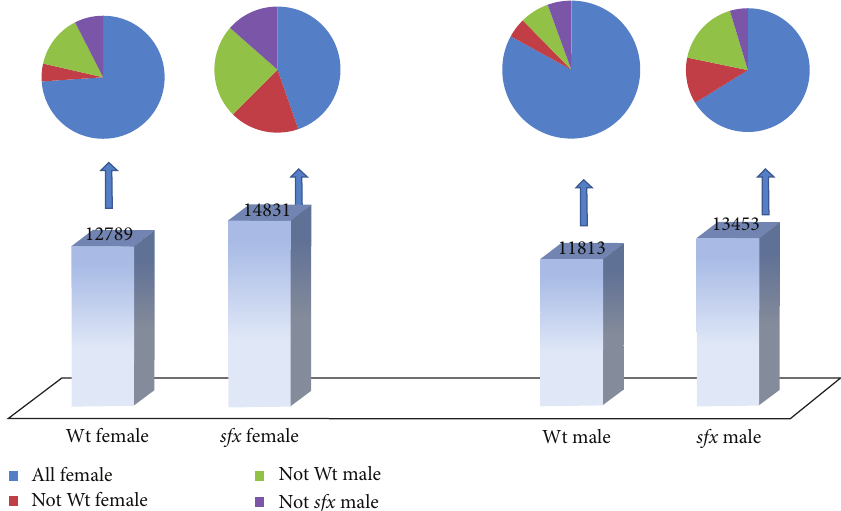
Figure 1: Comparison of whole genome gene expression levels in female and male in sfx and Wt controls. Bottom of the figure indicate the number of genes that are notated as “present” according to their expression level in each four categories ( sfx Female, sfx Male, Wt Female, and Wt Male). Not all genes presented in one category will be “present” in other categories. The up portion of the figure indicates the percentages of “present” or “absent” of genes in four types of mice, all of which are “present” in each category below in the bottom portion of the